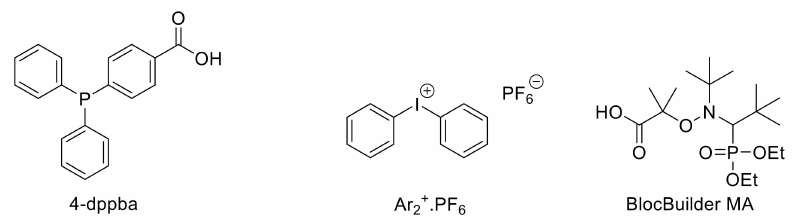
Figure 7. Chemical structures of